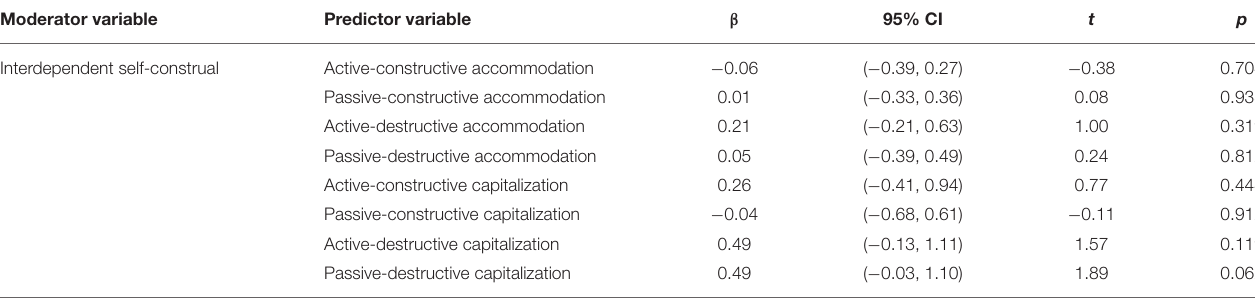
TABLE 7 | Moderation of interdependent self-construal for accommodation and capitalization reponses and relationship satisfaction. Moderator variable Interdependent self-construal